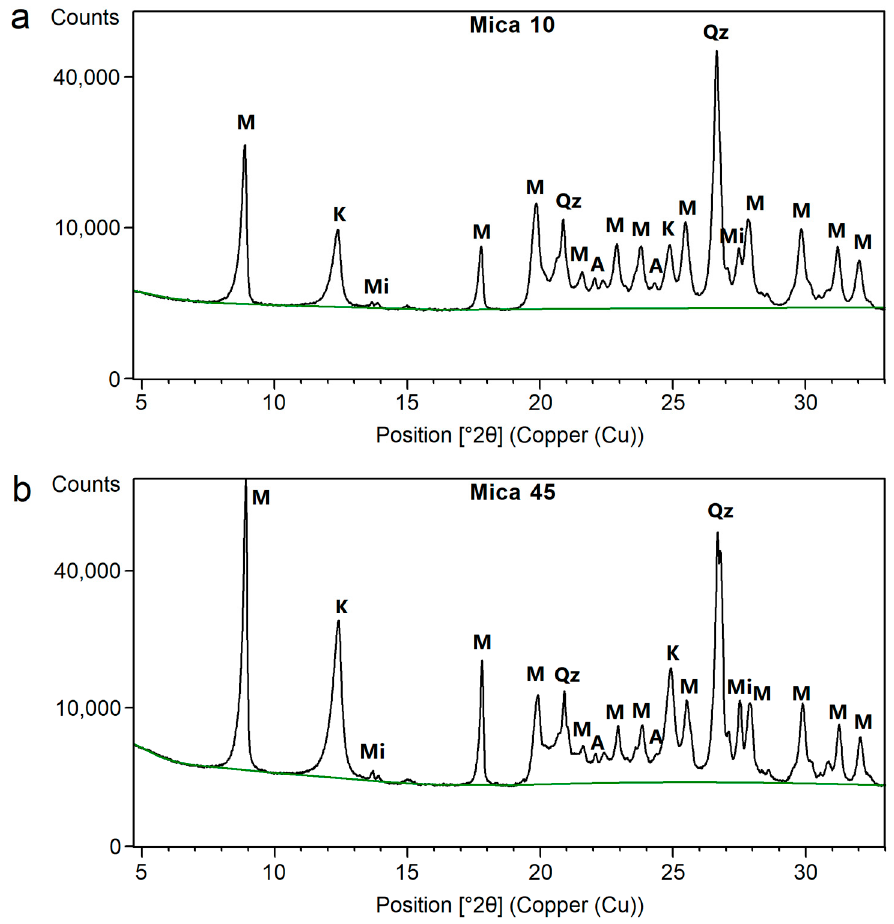
Figure 1. ( a ) XRD of Mica 10; ( b ) XRD of Mica 45 (M = muscovite, K = kaolinite, Mi = microcline, A = albite, Qz = quartz).